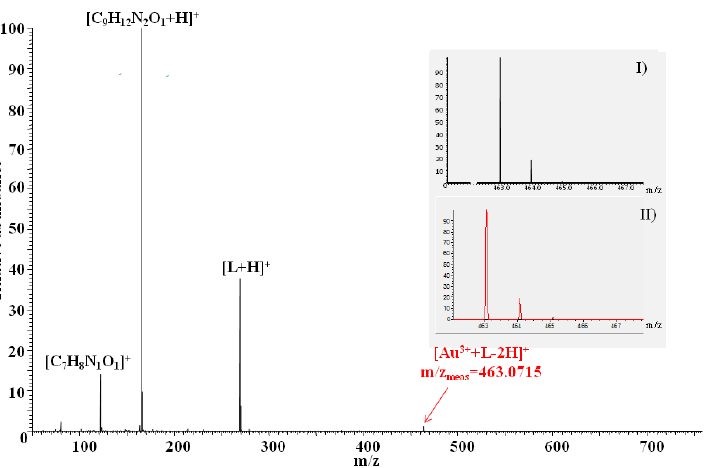
Figure 11. ESI-HRMS spectrum recorded for the sample of the separated organic phase after liquid– liquid extraction containing N,N' -bis(salicylidene)ethylenediamine (L) and Au 3+ ions. Inset shows the isotopic pattern for [Au 3+ +L-2H] + ions; ( I ) experimental, ( II ) theoretical. Unassigned minor signals correspond to ions not relevant to this study (e.g., formed by solvent molecules).